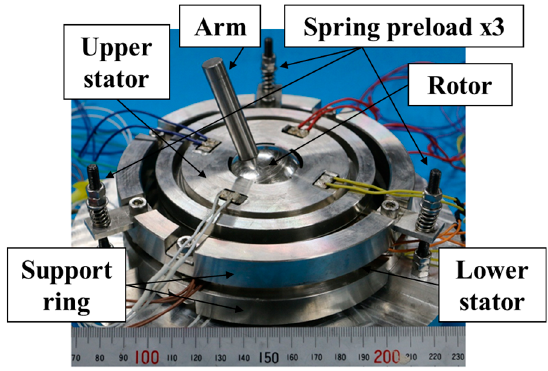
Figure 14. Photograph of assembled prototype of the sandwich-type MDOF-SUSM. Table 3. Basic characteristics of stators with support ring attached.